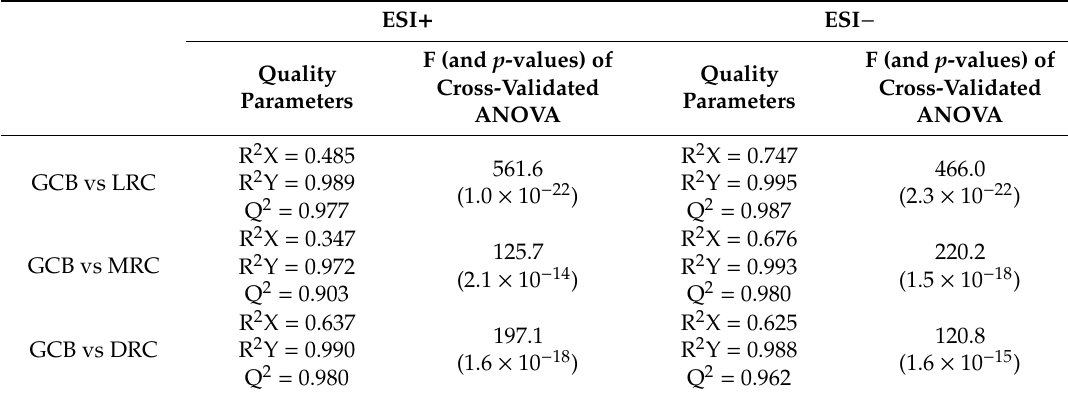
F (and p -values) of Quality Cross-Validated Parameters ANOVA R 2 X = 0.747 466.0 R 2 Y = 0.995 (2.3 × 10 − 22 ) Q 2 = 0.987